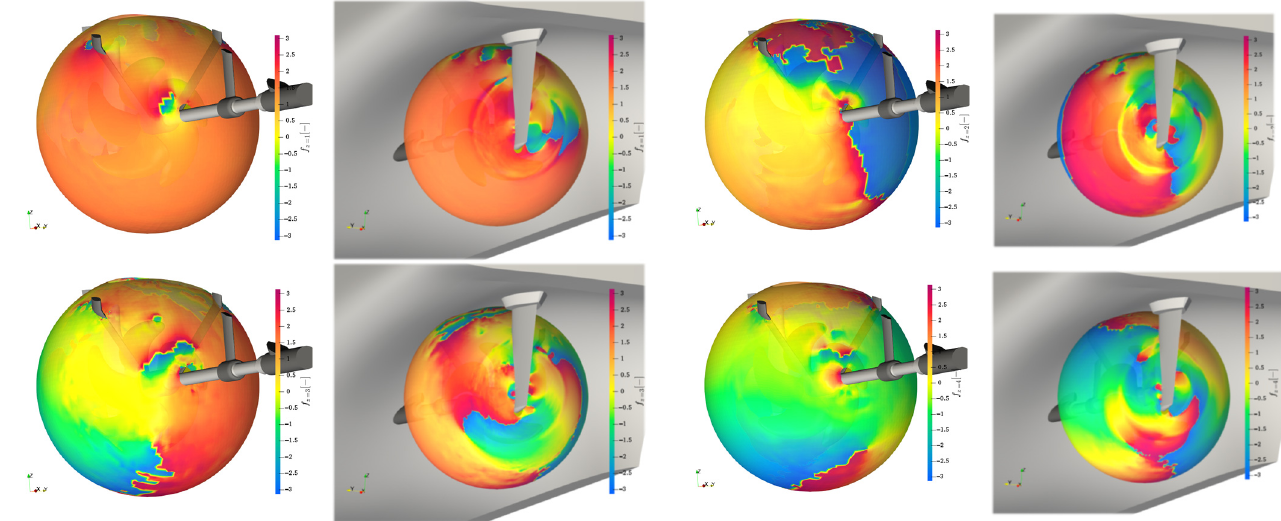
Figure 28. Complex phase angle information on the passive sphere from Figure